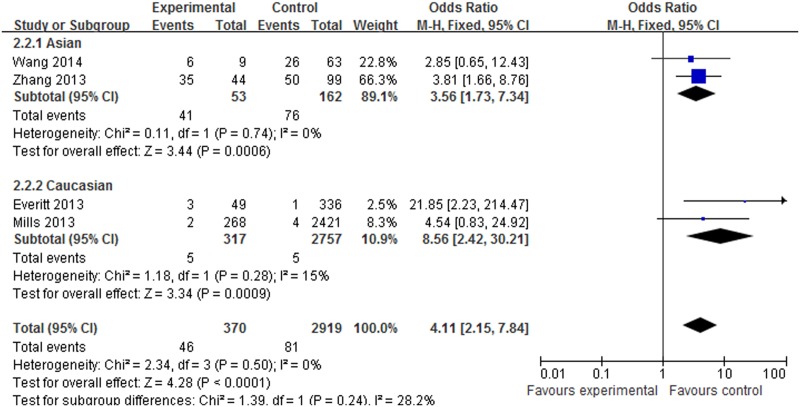
The forest plot for the association between SNP rs12252 of IFITM3 and influenza susceptibility in the homozygote comparison (CC vs. TT), subgroup analysis by different ethnicity.